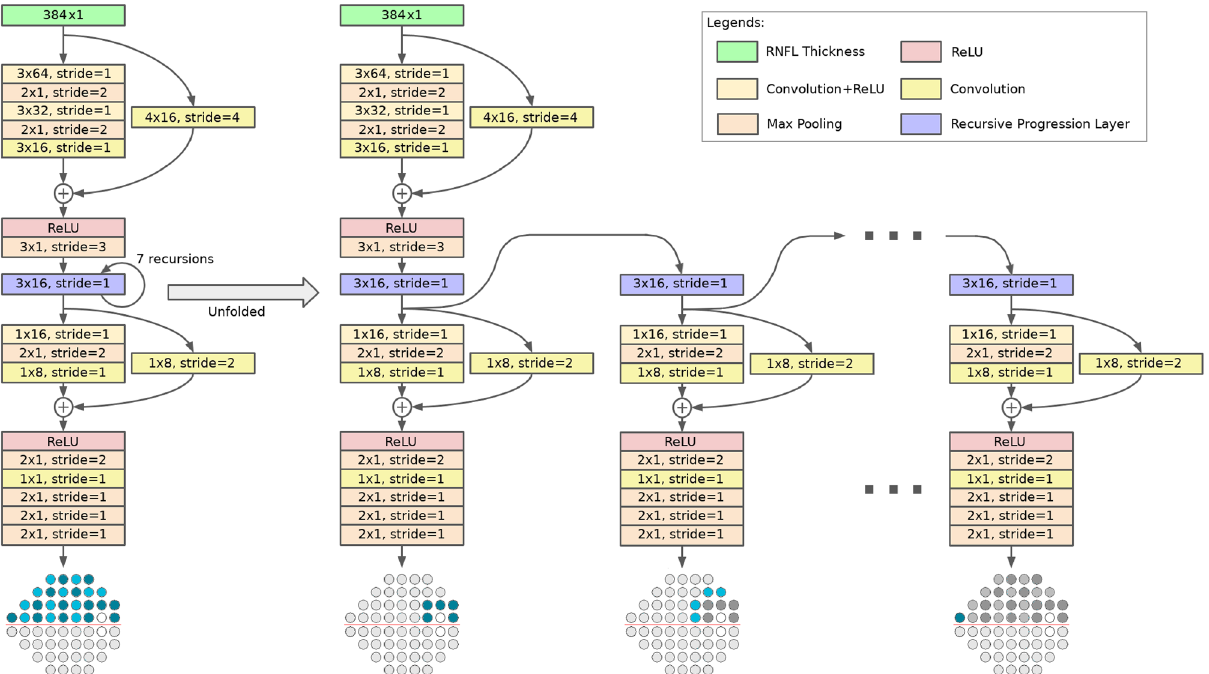
Figure 6. Details of the inferior sub-network of RetiNerveNet (best viewed in color): The sub-network has four main blocks. The first block consists of convolutional and max pooling layers, augmented by a convolutional skip connection. The second block only consists of the Recursive Progression Layer (RPL) which recursively models the outward spatial movement from the optic disc. None of the blocks except the RPL, correspond to any spatial movement along the retina. The next block consists of convolutional and max pooling layers, augmented by another convolutional skip connection. The final block consists of a single convolutional layer which combines the different representations obtained from the previous block into a scalar value. The subsequent max pooling layers bring down the dimension of the output to the intended size (5-dimensional vector). All convolutional layers are equipped with ReLU activations, except both the skip connections and the final convolutional layers of the corresponding blocks. The network respectively uses the first 5, 4, 4, 4, 4, 4, and 1 dimensions of the outputs after 7 successive recursive passes to obtain an estimate of the entire superior half of the visual field (consisting of 26 points). The visual field points estimated after successive passes are differentiated using contrasting